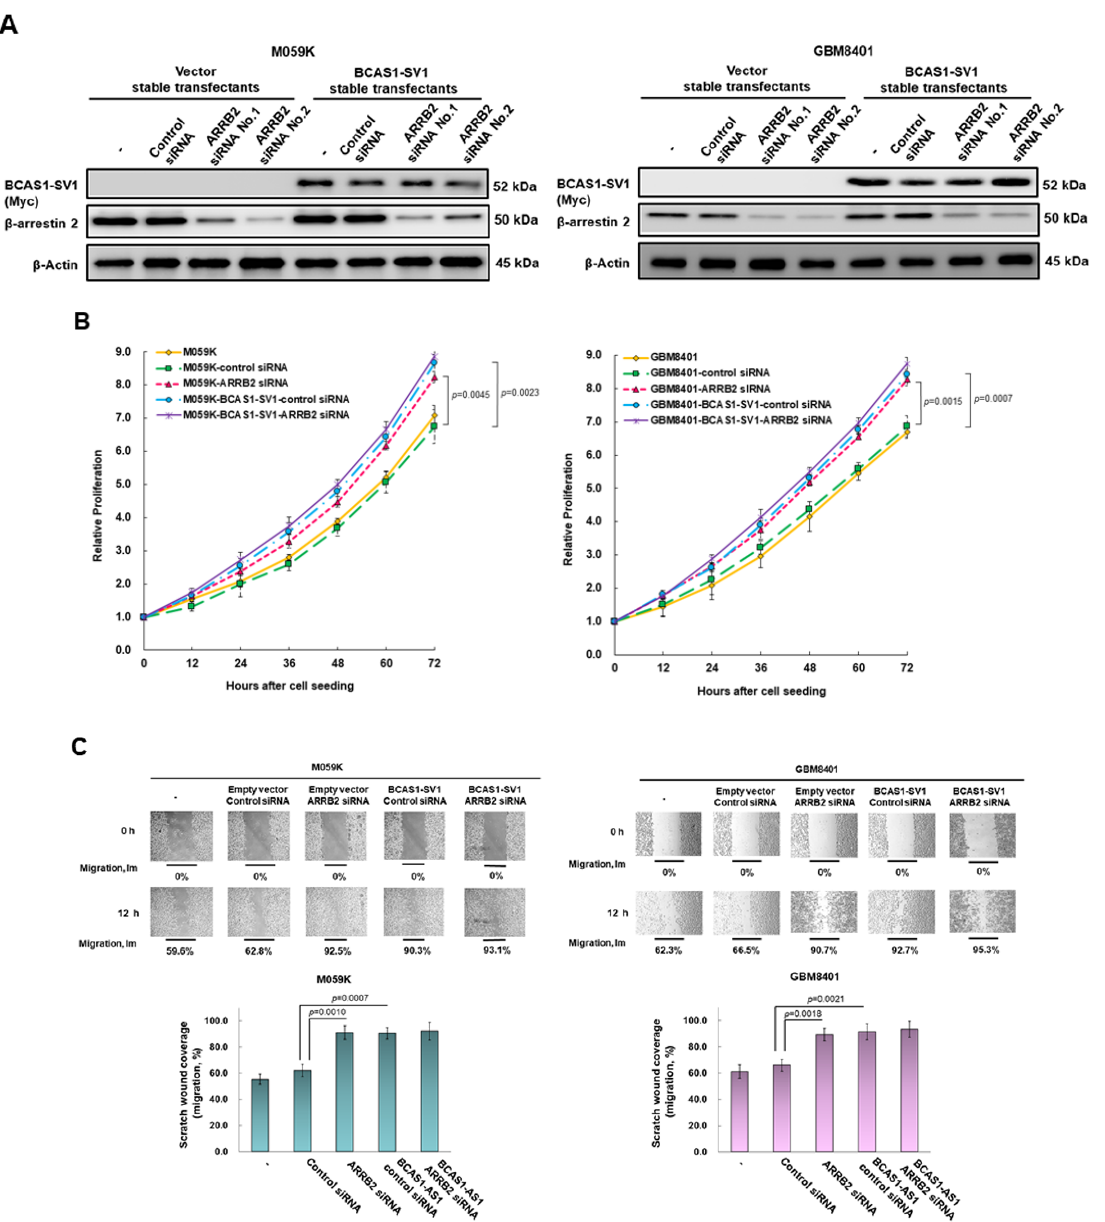
Figure 6. Downregulation of β -arrestin 2 increases the proliferation and migration of GBM cells and abolishes the effect of BCAS1-SV1. Vector-control- or BCAS1-SV1-overexpressing M059K and GBM8401 cells were transfected with ARRB2-specific or control nonspecific siRNAs, respectively. Twenty-four hours after transfection, cthe ells were examined for proliferation and migration. ( A ) BCAS1-SV1 and β -arrestin 2 expression were analyzed by Western blotting. Anti- β -arrestin 2 and anti-myc antibodies were used to detect β -arrestin 2 and BCAS1-SV1. β -actin was an internal control. ( B ) Cell proliferation of the control siRNA-treated or ARRB2 siRNA-treated groups in M059K (left) and GBM8401 (right) cells was determined by CellTiter Blue Cell Viability assay. ( C ) Cell migration of the control siRNA-treated or ARRB2 siRNA-treated groups in M059K (left) and GBM8401 (right) cells was determined by scratch wound assay. Bars, width of the initial scratch gap at the start of the experiment. A migratory index, Im, was defined as Im = (g0 − g12)/g0, where g12 and g0 are the gap widths at time 12 and time 0, respectively.